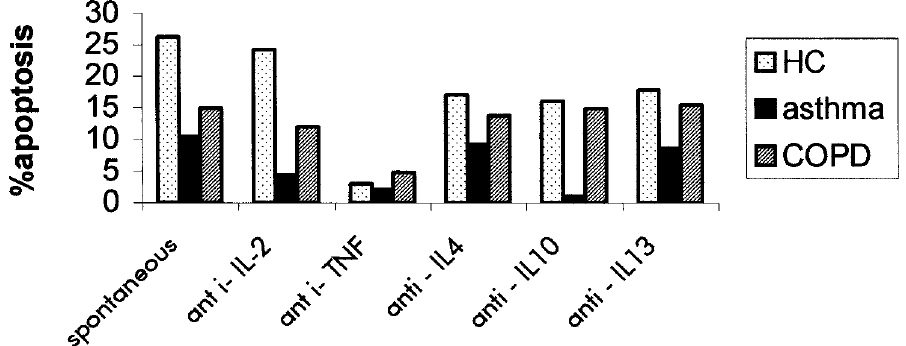
FIG. 1. Percentage of apoptosis in patients with asthma ( n = 10), in patients with COPD ( n = 12), and in healthy controls (HC) ( n =